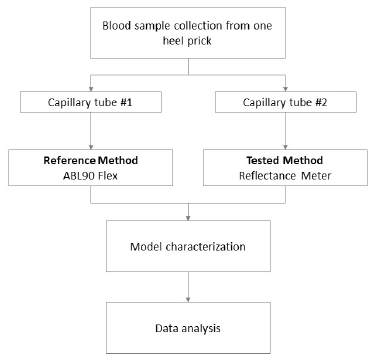
Figure 3. Workflow of procedure for data acquisition, model characterization, and clinical test.